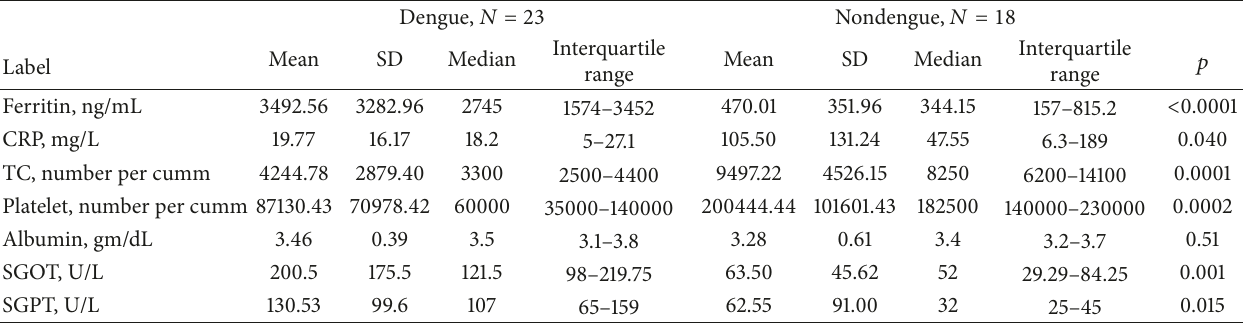
Table 1: Comparative analysis of pertinent parameters for the dengue and nondengue cohort.